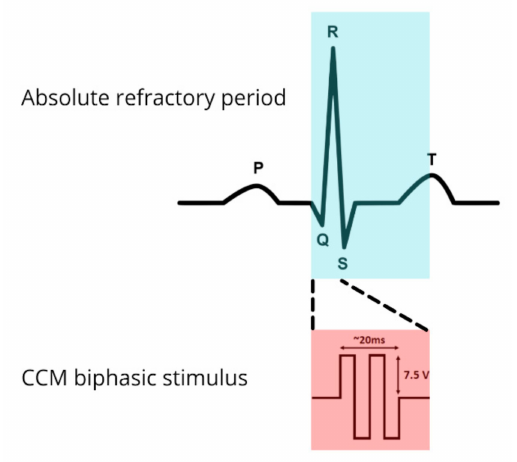
Figure 1. Cardiac contractility modulation biphasic stimulus located on an electrocardiogram